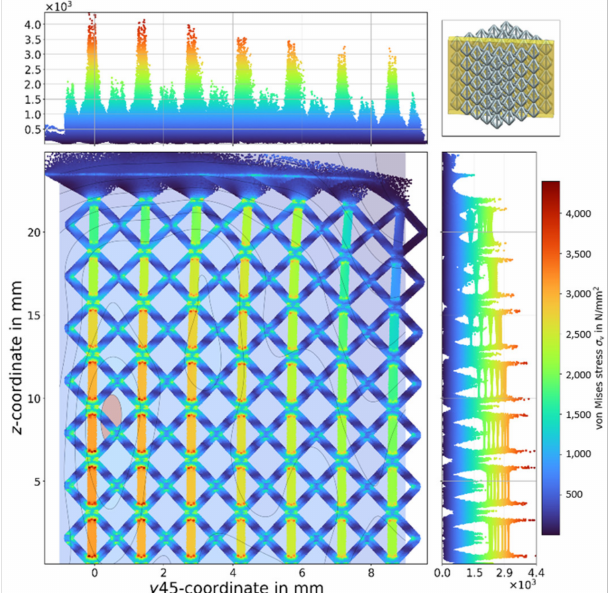
Figure 13. Von Mises stress of the f2ccz lattice with cones as the load introduction feature—diagonal view cut.